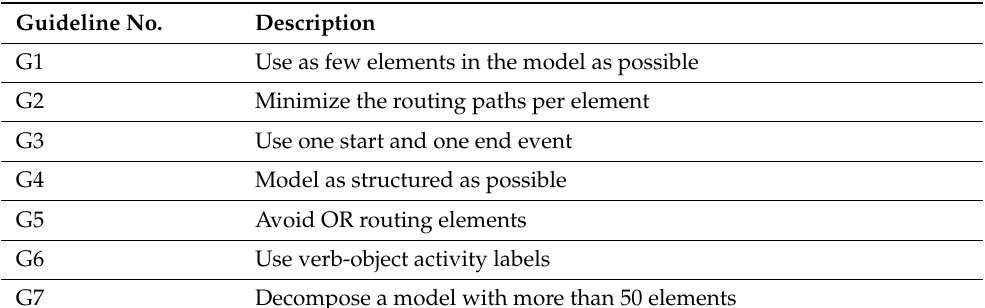
Table 1. Overview of the 7PMG. Source: [60]. Guideline